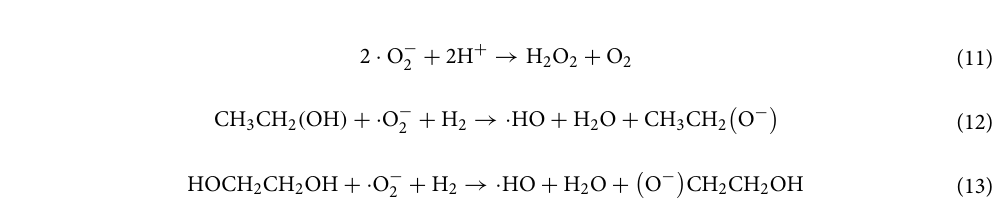
Figure 8. Photos of the plate are compared with the control and the solution containing nanobubbles treatment after 48 h of